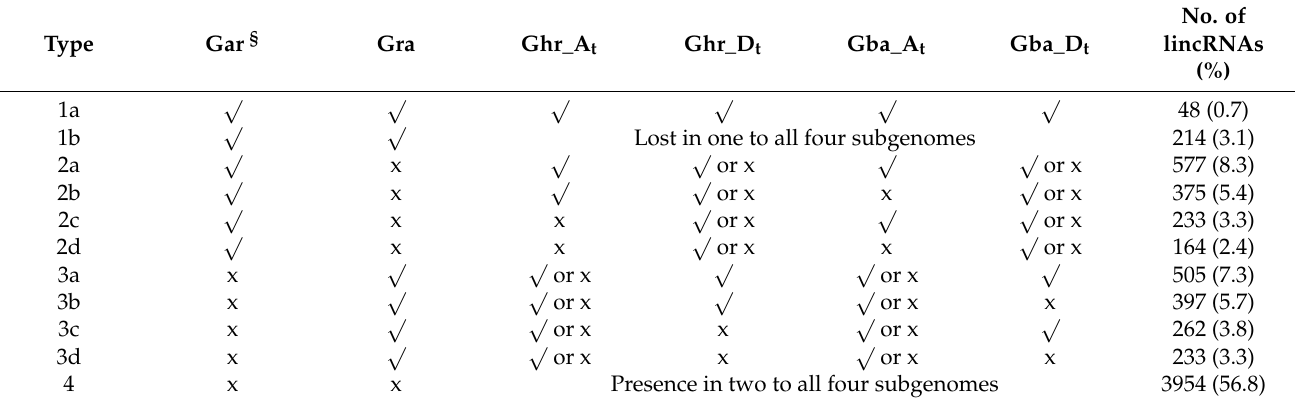
Table 1. Conservation of the syntenic and transcribed lincRNAs of the one2one